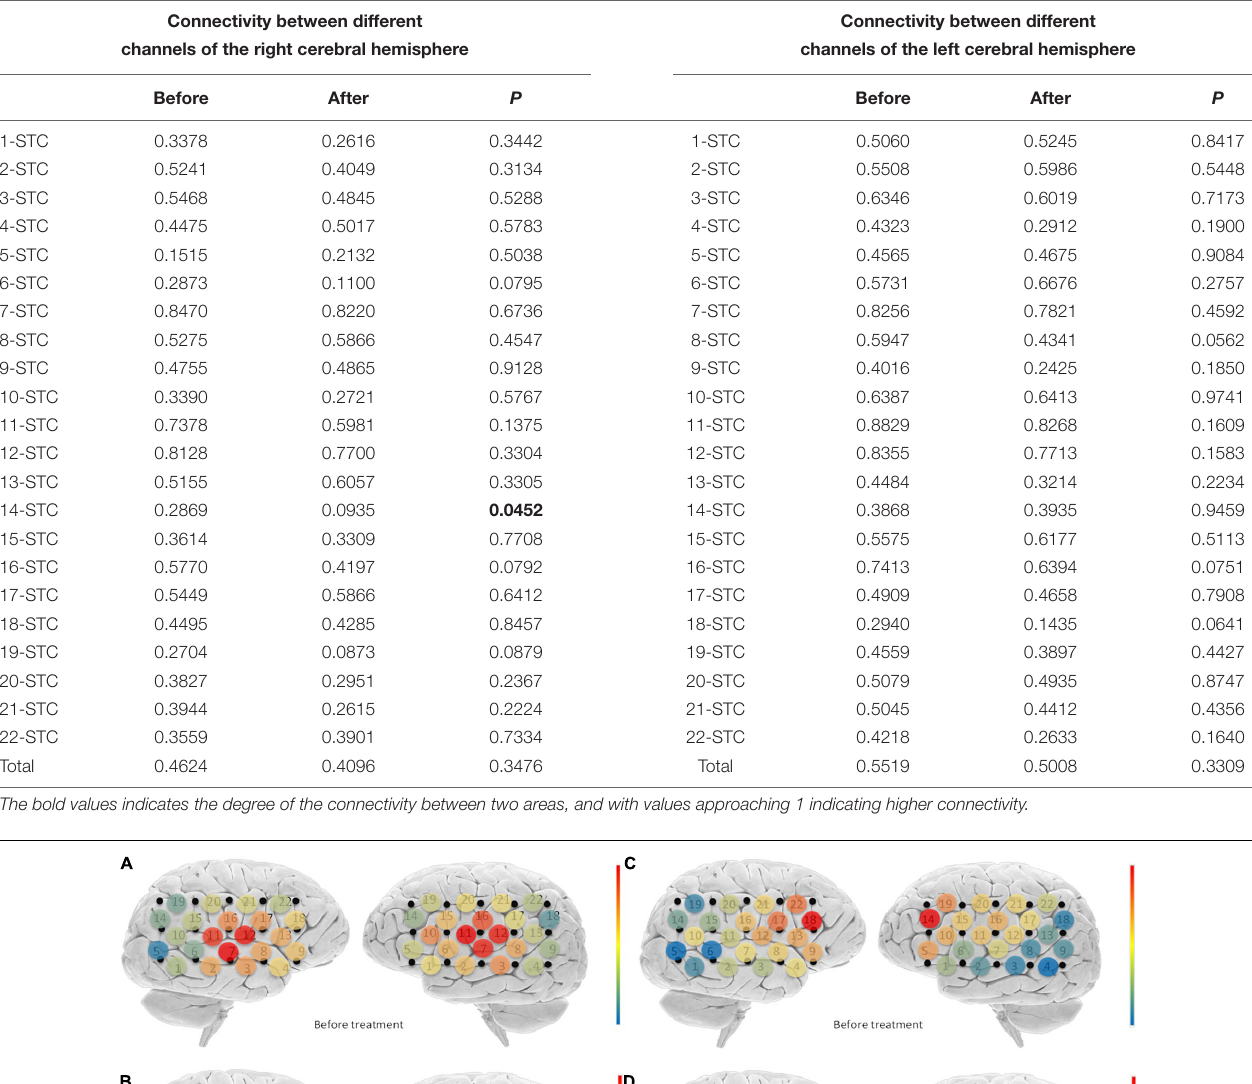
TABLE 3 | Connectivity between STC and different channels.